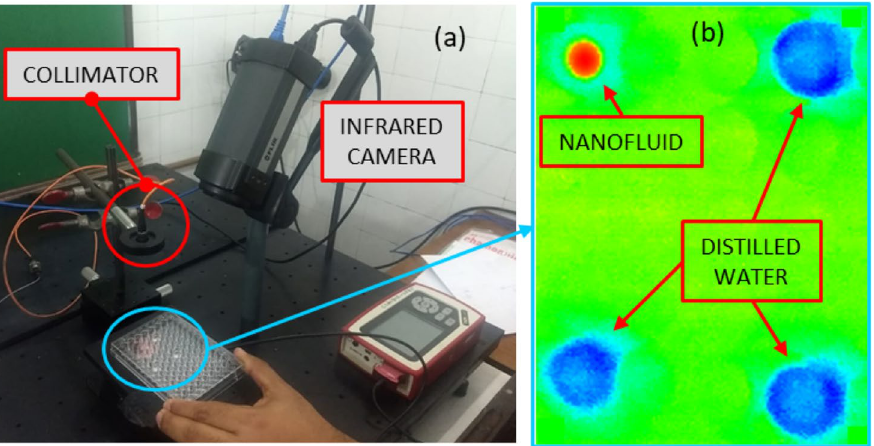
Figure 8. ( a ) Apparatus for photothermal analysis and ( b ) typical thermal image during the heating of the